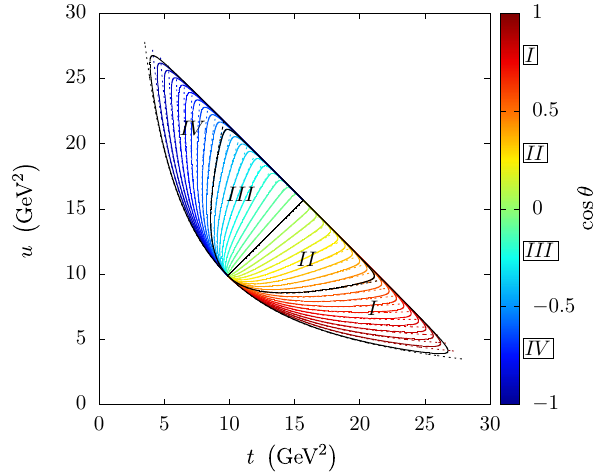
Fig. 2 The region for Dalitz plot of B → D μ + μ − showing the vari- ation of cos θ inside it. The solid lines take into account the mass of muon, but the dashed lines are for the massless muon case. The Dalitz plot can be divided into four segments, denoted by I, II, III, and IV, according to the region of cos θ as shown along the color bar here. The Dalitz plot can be obtained in any frame of reference. We need not go to the Gottfried–Jackson frame for the Dalitz plot, the laboratory frame is